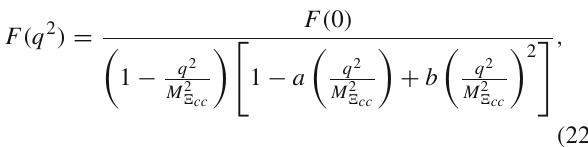
, f s , g s and g s in a three-parameter form on q 2 ( a ) and the dependence of the form factors f v 1 2 1 2